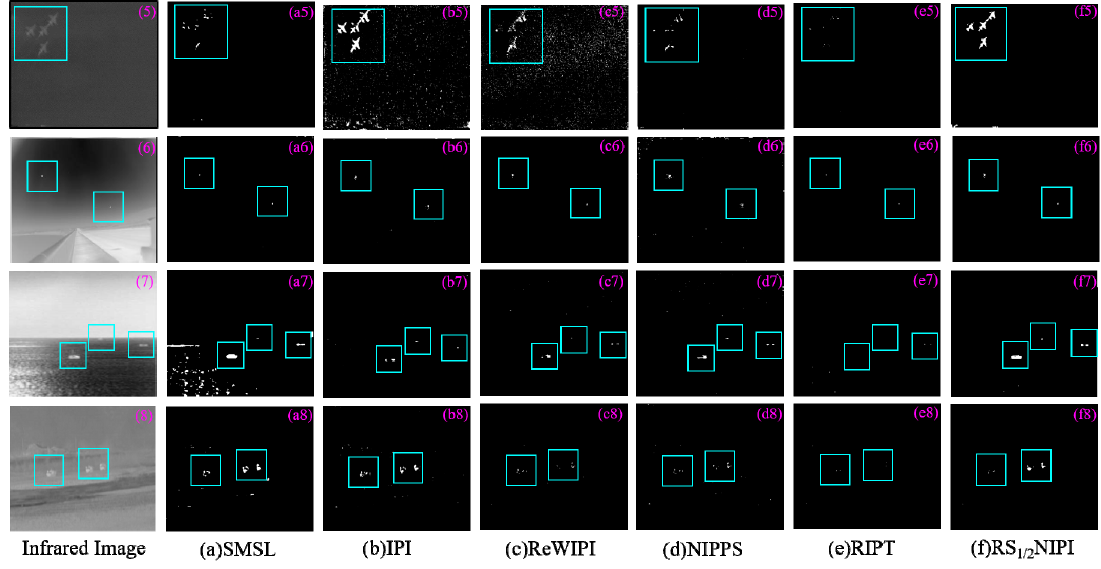
Figure 9. Representative multiple targets images from the datasets and the separated target images obtained by six low-rank recovery-based methods. ( 5 )–( 8 ) are four representative multiple targets images from the tested datasets.